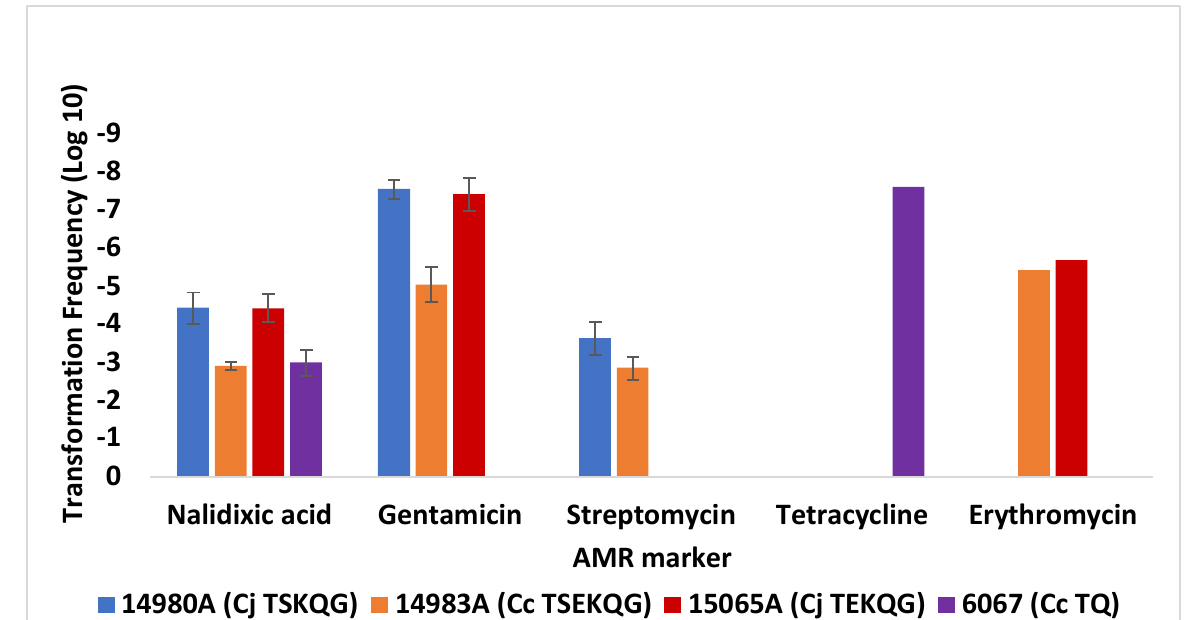
Figure 4. Transformation of C. jejuni FSIS 18110577 with DNA from a panel of C. jejuni and C. coli donors. Transformation frequencies are averages from two or more independent trials for each re- cipient strain–donor DNA pair, and transformations were carried out as described in Materials and Methods. Cj and Cc in front of strain designations indicate C. jejuni and C. coli , respectively. AMR phenotype designations in strain names are as in the legend to Figure 2. The error bars on the col- umns with the transformation frequency data for tetracycline and erythromycin resistance were too stitutions, whereas nalidixic-acid-resistant transformants only need to acquire a single gene, small to be visible. gyrA , harboring the substitution associated with (fluoro)quinolone resistance [13,39,40].